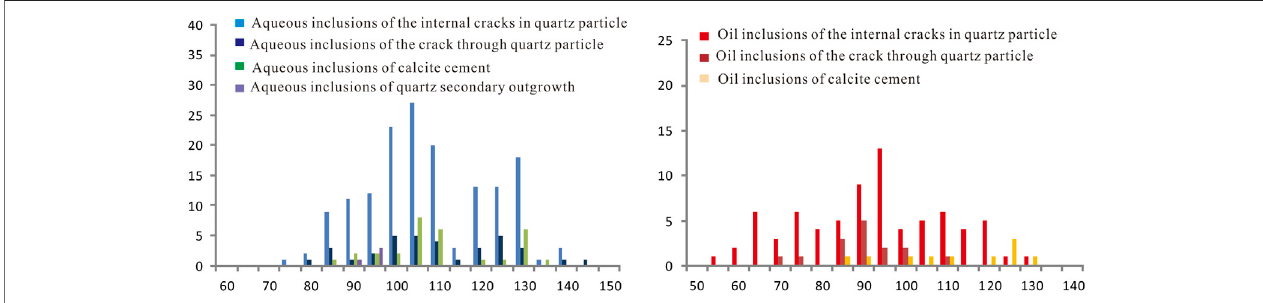
FIGURE 5 | Two-dimensional slices of continuous scanning of oil inclusions in the Fang-182 well in the Fuyu oil reservoir by CLSM.